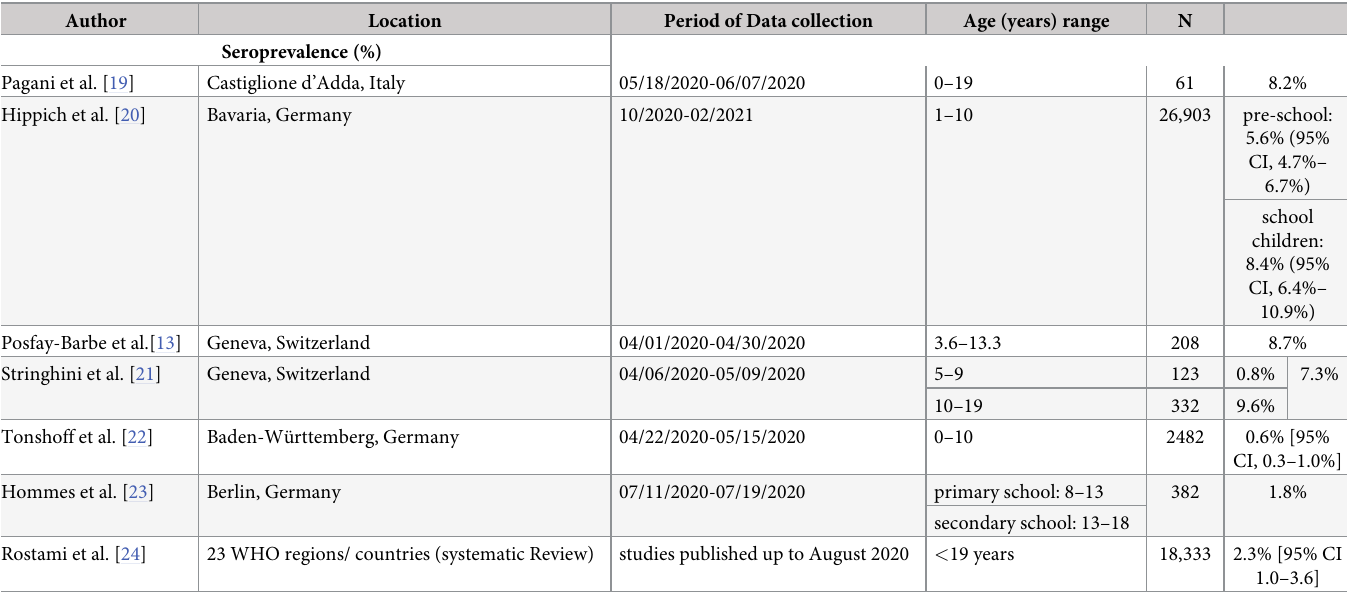
Table 7. Overview: Studies measuring seroprevalence in